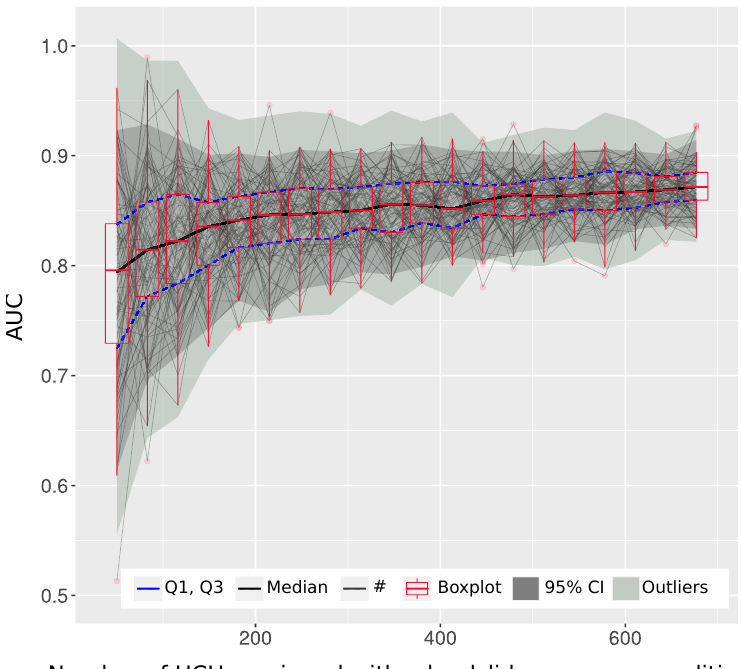
Figure 8. Distribution of the Area Under the ROC Curve (AUC) values of the 2000 model runs with different proportions of number presence condition.